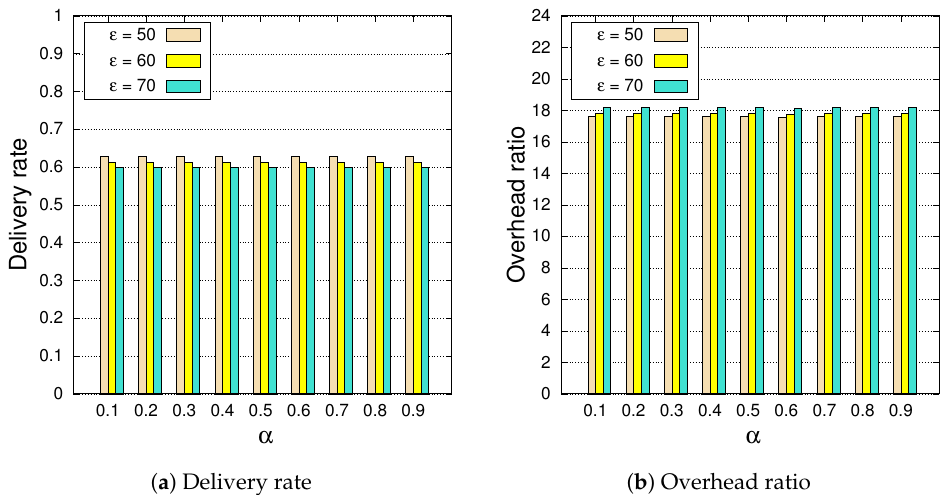
Figure 5. Results by MPMF with different values of α and (cid:101) under TVCM trace (TTL = 5 h and buffer size = 10